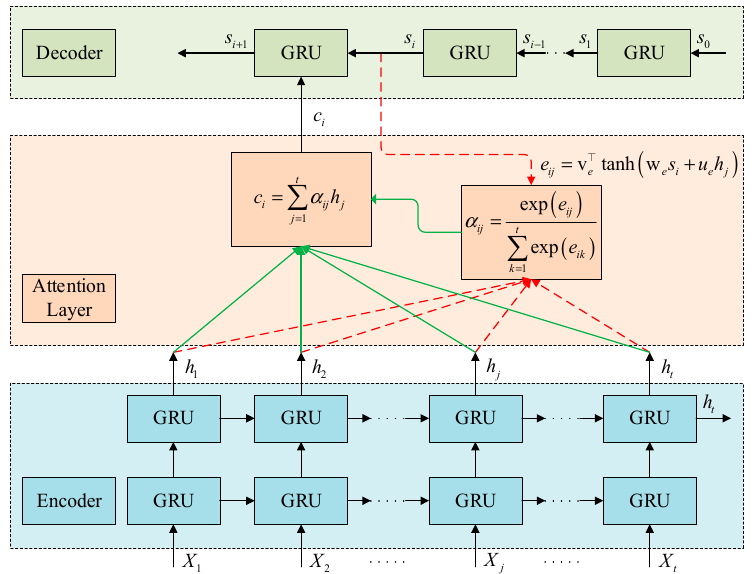
Figure 2. Temporal attention layer structure.